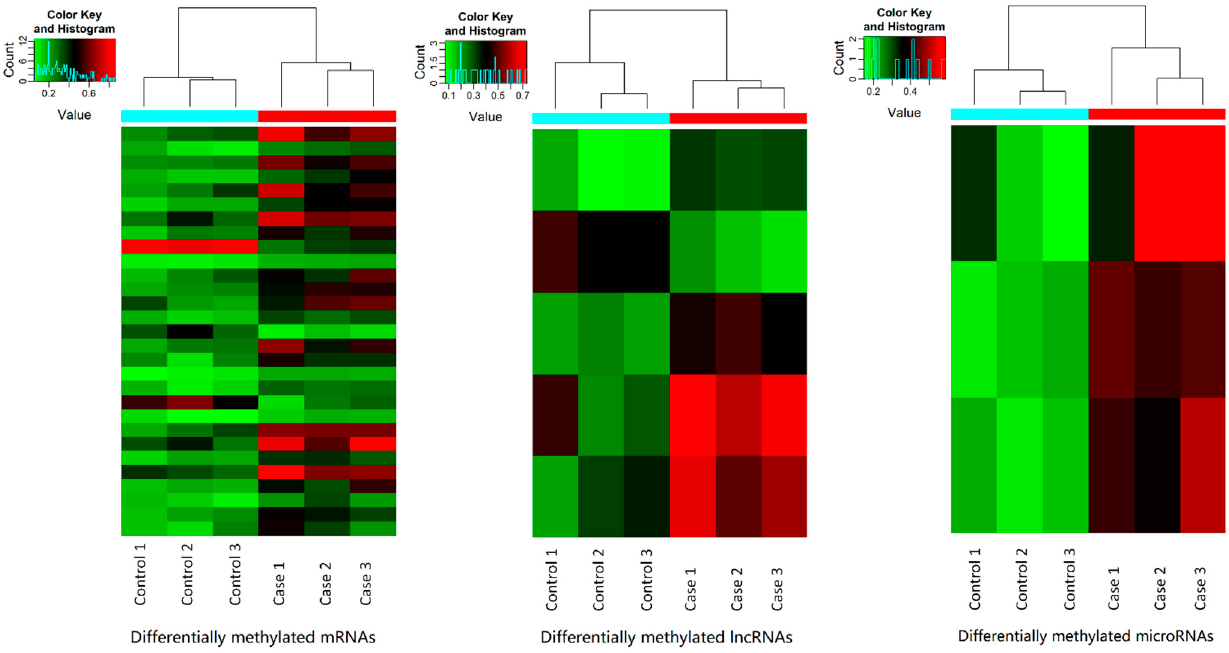
Figure 3. Heatmaps visualing differentially methylated mRNAs ( n = 29), lncRNAs ( n = 5), and miRNAs ( n = 3). The red–green gradient color scheme represents the high and low m6A-methylation levels as referenced in the Color Key. The top dendrogram shows the closeness among the samples. The sample group membership is indicated by the color bars above the heat